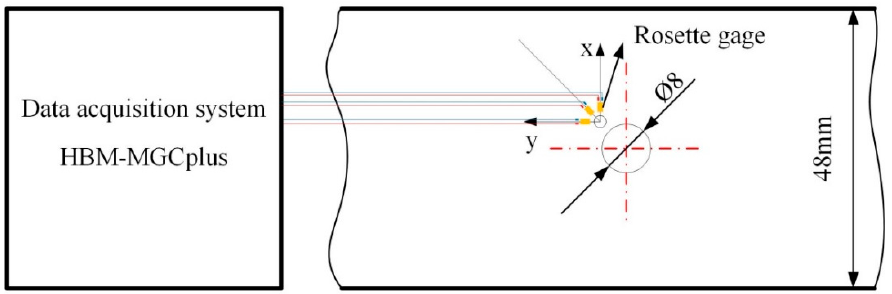
Figure 8. Schematic illustration of the through-hole drilling method.